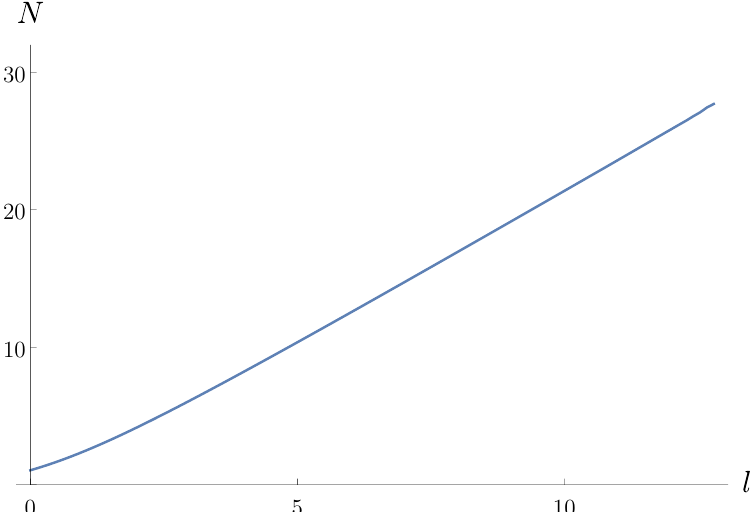
Figure 3 . Number of e-foldings N as a function of l , which parametrizes the distance ∆ between the x -coordinates of p 00 and p for the ( λ, k ) model, viz. l = − log ∆ + const.. 1